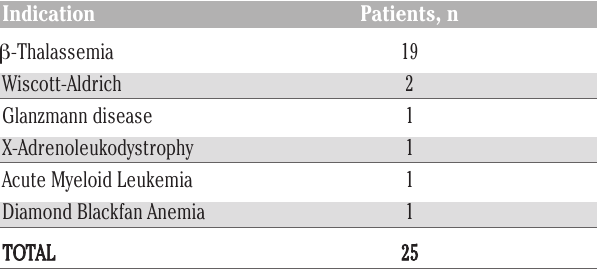
Table 1. Cycle participations of patients and indications for HLA Typing.